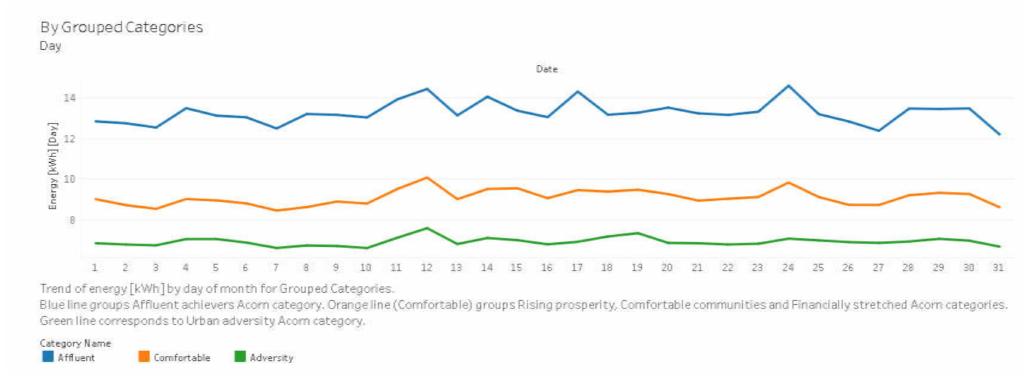
Figure 4. Average energy consumption for each day of August 2013 for each grouped